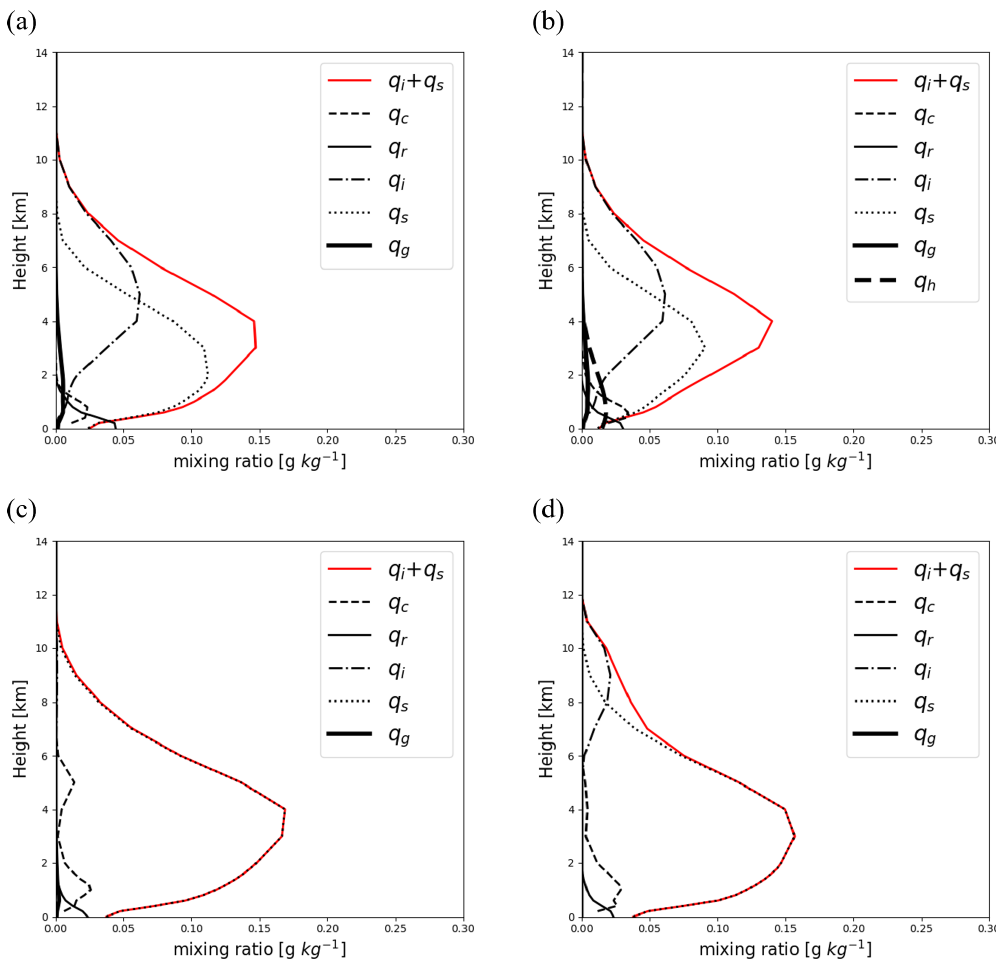
Figure 10. The same as Fig. 8 but representing the results for case